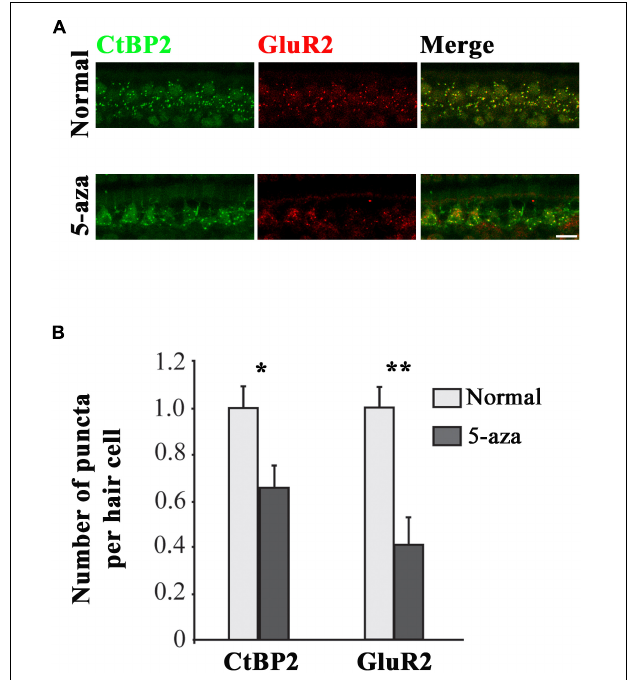
FIGURE 2 | Expression of C-terminal-binding protein 2 (CtBP2) and GluR2 was observed in the 5-aza-treated mice. (A) Expression of CtBP2 and GluR2 in the surface preparation of the basilar membrane of the normal hearing and 5-aza-treated mice. Scale bar: 50 µ m. (B) Quantification of CtBP2 and GluR2 expression. The number of CtBP2 and GluR2 puncta per inner hair cell was normalized to 1 for the normal hearing mouse. Data are means ± SEM. Statistical analysis was performed by Tukey’s honestly significant difference (HSD) test. * indicates p < 0.05; **indicates p <